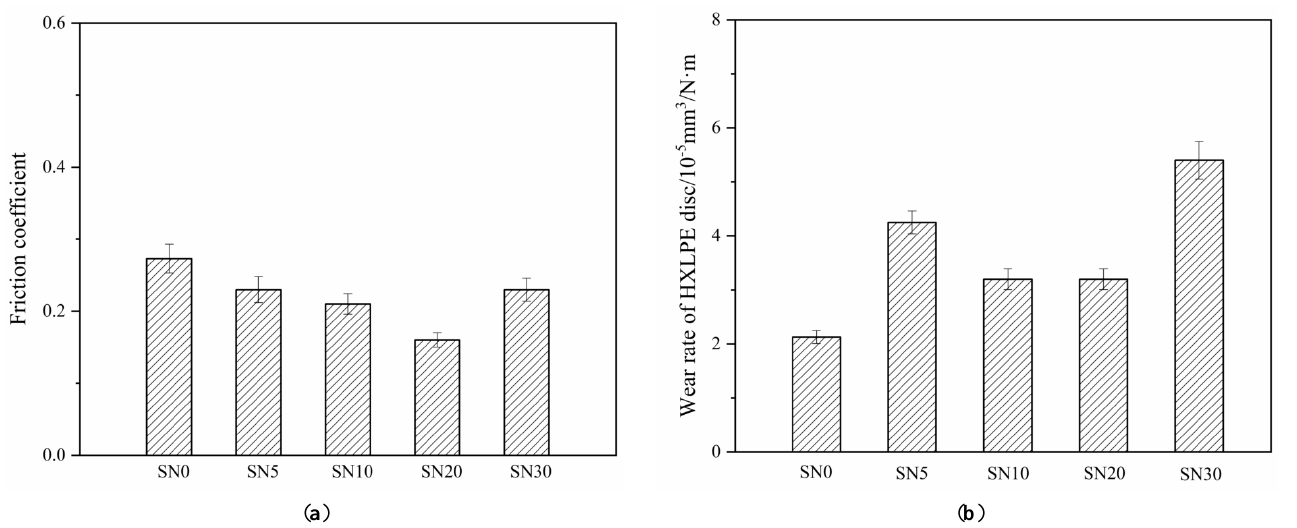
Figure 3. ( a ) Friction coefficients of Si 3 N 4 -hBN/UHMWPE pairs in SBF and ( b ) the wear rates of UHMWPE discs.